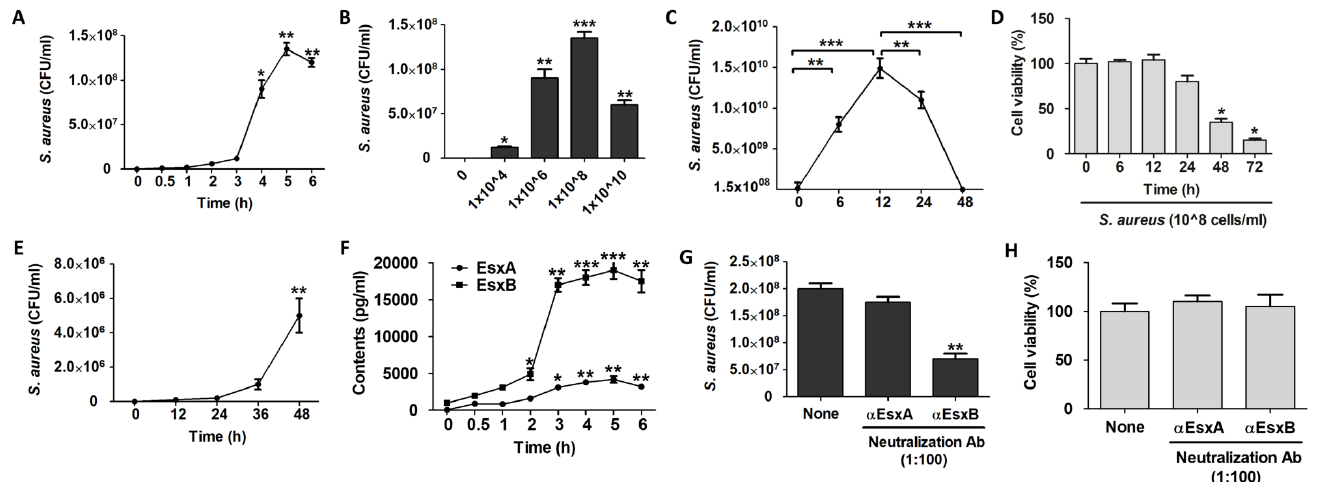
Figure 1. EsxB-mediated internalization of S. aureus . ( A ) The colony forming unit (CFU) of intracellular S. aureus according to the incubation time of S. aureus and HaCaT cells. ( B ) The CFU of intracellular S. aureus according to the dose of S. aureus administered to HaCaT cells. (C to E) HaCaT cells were cocultured with S. aureus for 6 h, washed, and further incubated in a fresh medium with or without gentamycin for the indicated times. Intracellular CFU ( C ), cell viability ( D ), and extracellular CFU from the culture media ( E ) were counted. ( F ) The amount of EsxA and EsxB was examined using indirect ELISA with culture supernatants from HaCaT cells incubated with S. aureus for the indicated times. (G to H) HaCaT cells were pretreated with anti-EsxA and anti-EsxB antibodies for 30 min, and then were incubated with S. aureus for 6 h. Intracellular CFU were counted ( G ), and a cell viability assay was performed ( H ) after 24 h of further incubation in a fresh medium containing gentamycin. The data displayed are the mean ± SD of three independent experiments. Statistical analysis was conducted using a one-way ANOVA (A to F) or unpaired two-tailed t test ( G ). * p < 0.05, ** p < 0.01, *** p < 0.001 vs. 0 or None.